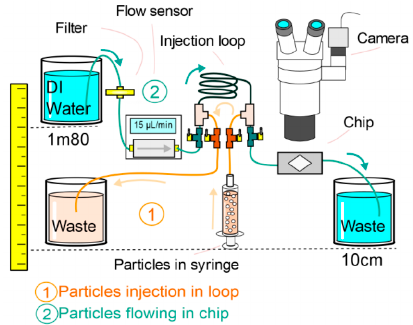
Figure 10. Schematic of the experimental set up used to study velocity flow in the microfluidic